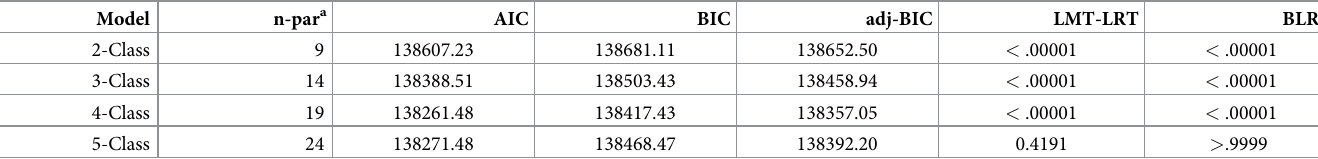
Table 1. Model fit indices.